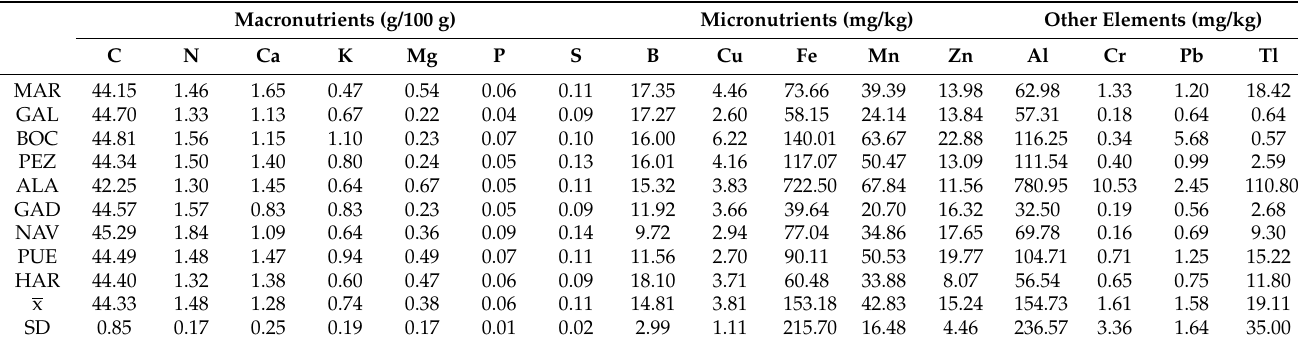
Table 4. Average values in foliar samples of macronutrients (g/100 g), essential microelements (mg/kg) and other elements of interest (mg/kg) concentrations, total averages (x) and their standard deviations (SD) for each element. Macronutrients (g/100 g) Micronutrients (mg/kg) Other Elements (mg/kg)